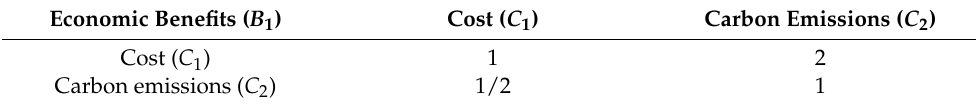
Table 5. Matrix relationship between layer C and layer B 1 .